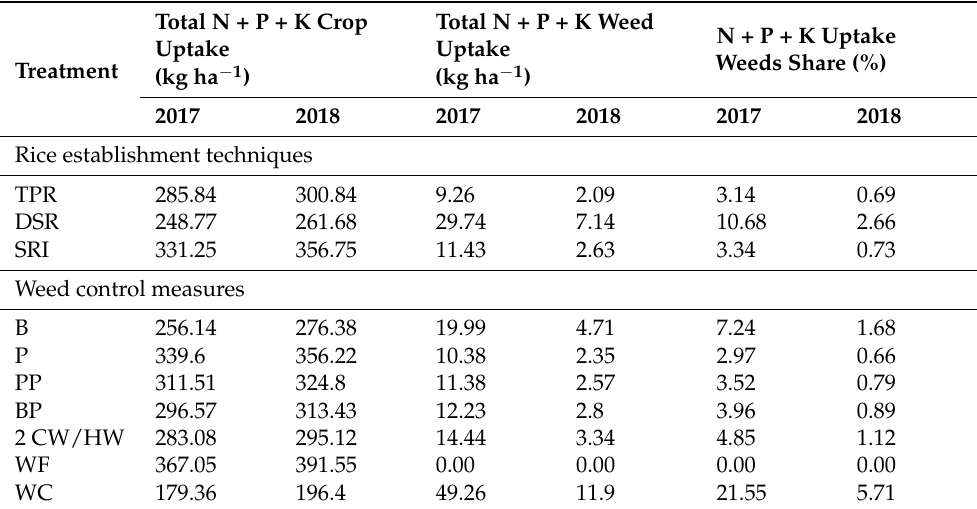
Table 9. Influence of rice establishment techniques and weed control measures on total nutrient uptake of the crop (kg-ha − 1 ).